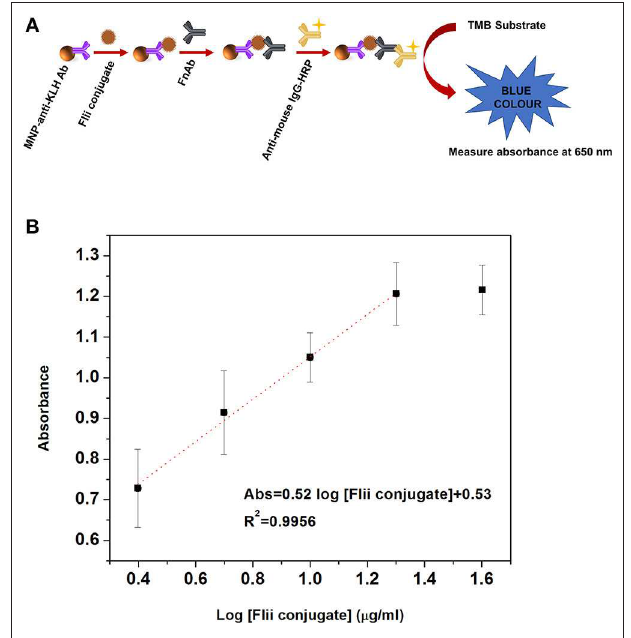
FIGURE 3 | Scheme (A) and dose response curve (B) for the colorimetric ELISA detection of Flii peptide conjugate, previously isolated using